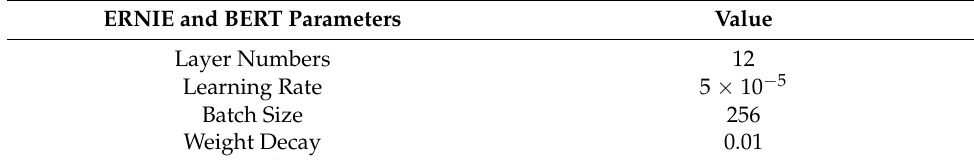
Table 2. Super parameters of ERNIE and BERT model training.